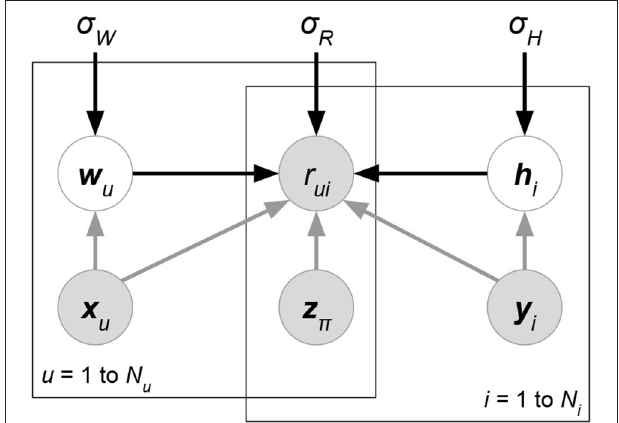
FIGURE 5 | Graphical interpretation of a discriminative probabilistic matrix factorization whose attributes X , Y , Z are given for ratings and latent factors. User and item-relevant attributes X , Y could affect the generation of latent factors W , H , or ratings R , while rating-relevant attributes Z typically determine the rating prediction R . The models of this class may eliminate some of the gray arrows to imply additional independence assumptions between attributes and other